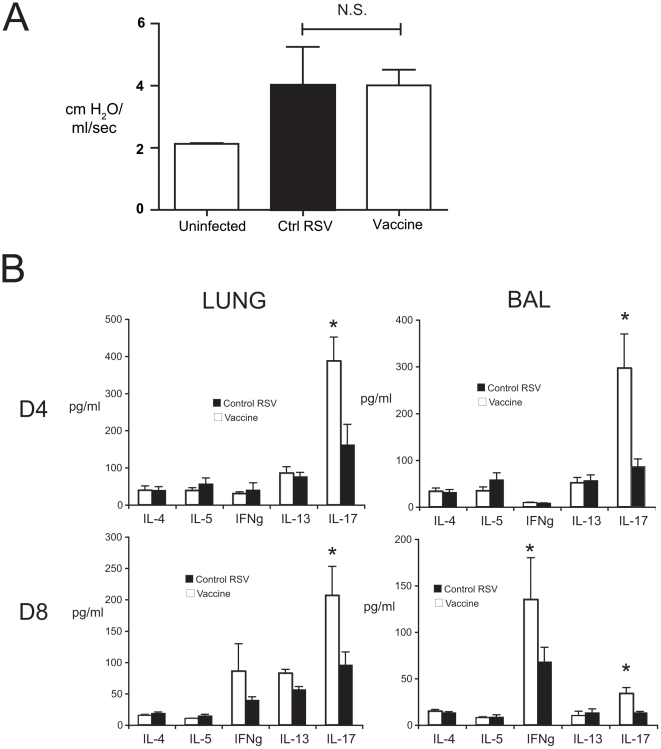
NE-RSV immunization does not promote Th2-mediated immunopotentiation.Mice were vaccinated with NE-RSV as described. Control and vaccinated mice were challenged at day 56. In (A), airway hyperreactivity was assessed at day 8 post-challenge via invasive plethysmography. Columns represent the increase in airway resistance following a single, optimized intravenous dose of methacholine. In (B) cytokine levels in the bronchoalveolar lavage (BAL) and lung homogenate (Lung) were assessed at day 4 and 8 post-challenge. Bars represent the mean of 6–8 mice per group ± SEM. * = p<0.05.